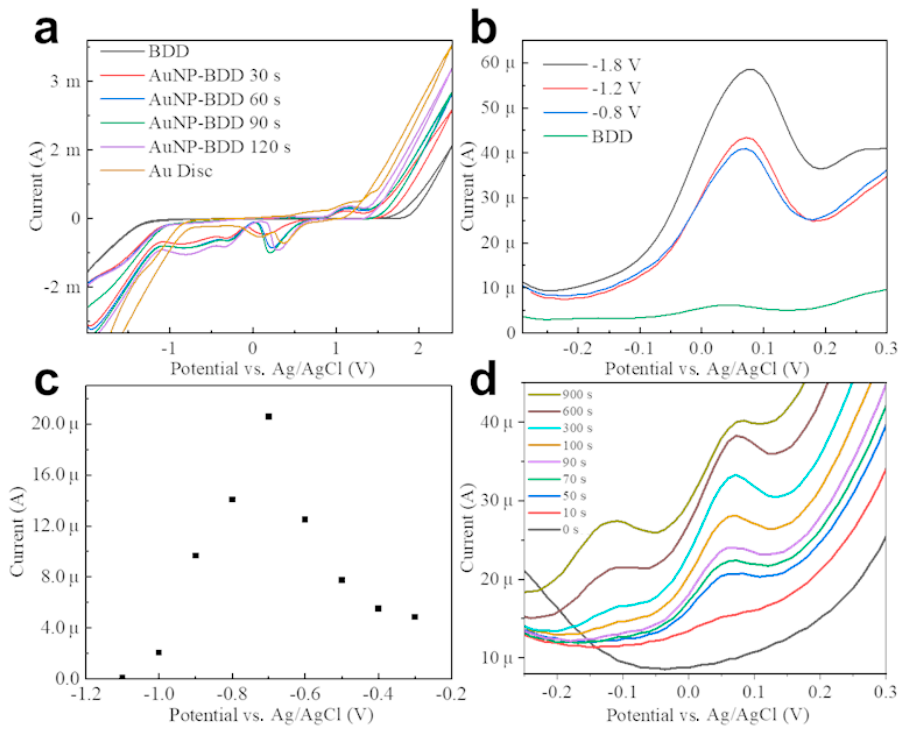
Figure 3. (a ) Potential windows of AuNP-BDD, bare BDD, and gold disk electrodes in AcONa. The inset graph magnifies the measured current for the potential range of − 1 to +1 V. ( b ) Current peaks obtained using square-wave anodic stripping voltammetry (SWASV) in a solution containing 100 ppb of As(III) for AuNP-BDD electrodes obtained using different voltages for AuNP deposition. ( c ) Variation in the electrodeposition efficiency with the voltage applied for 300 s to obtain the optimal AuNP-BDD electrode by stripping. ( d ) Current vs. potential curves obtained to determine the optimum electrodeposition time at an applied voltage of − 0.7 V; SWASV is conducted in a solution with 10 ppb of As(III) for different times in the range of 0 to 900